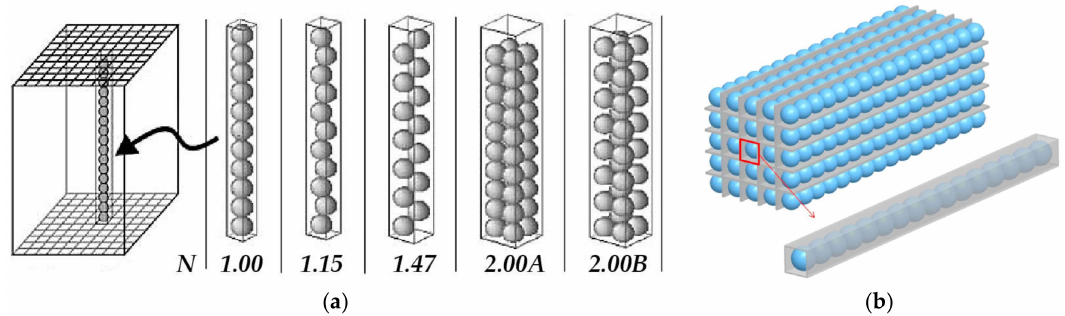
Figure 1. Schematic of ( a ) composite structured packing (CSP) by Calis et al. [3] and Rokmes et al. [4]; and ( b ) grille-sphere composite structured packed bed (GSCSPB) by Wang et al.